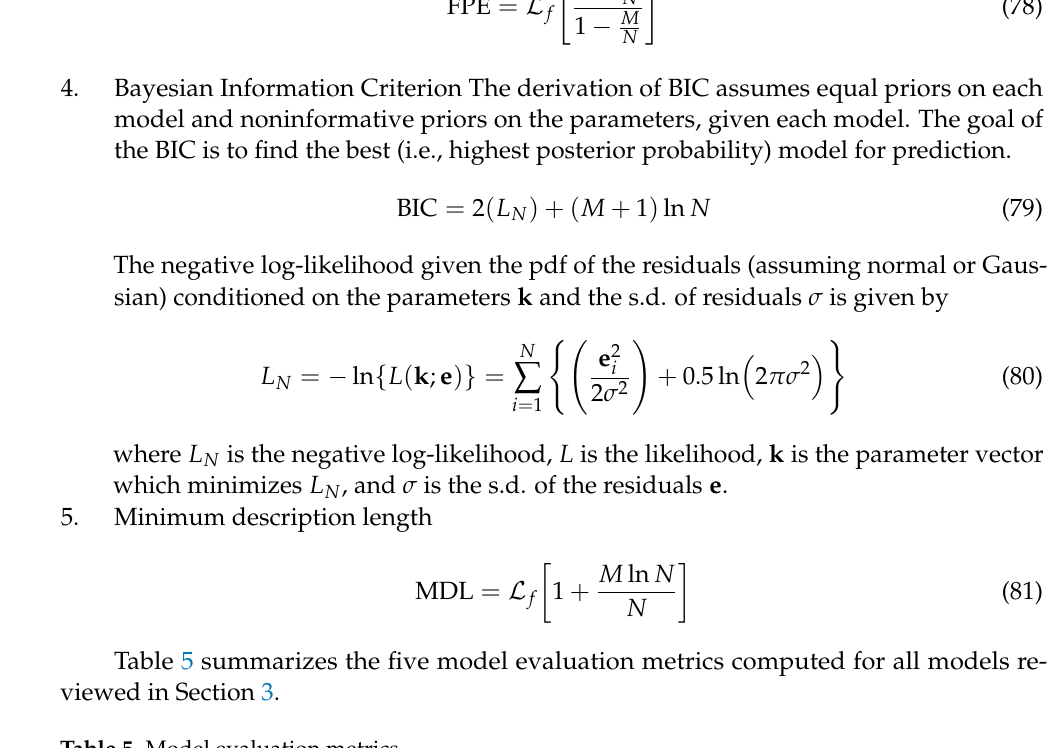
Table 5. Model evaluation